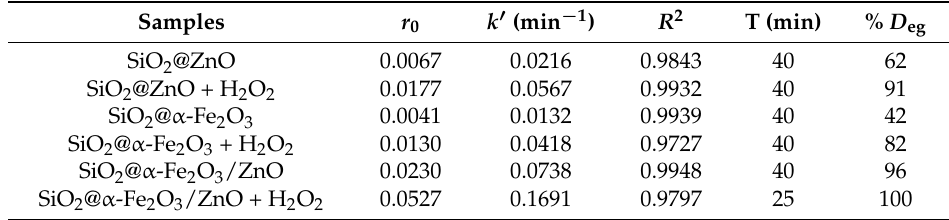
Table 2. Statistical analysis of pseudo-first-order kinetics for photocatalytic and photo-Fenton degradation reactions towards